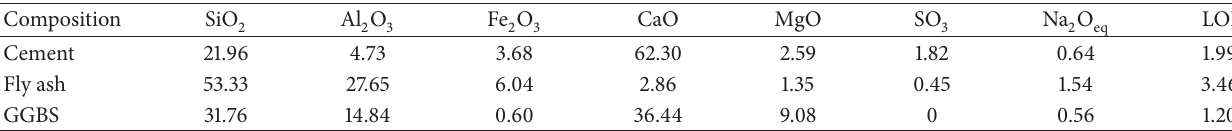
Table 2: Chemical compositions of raw materials w/%.